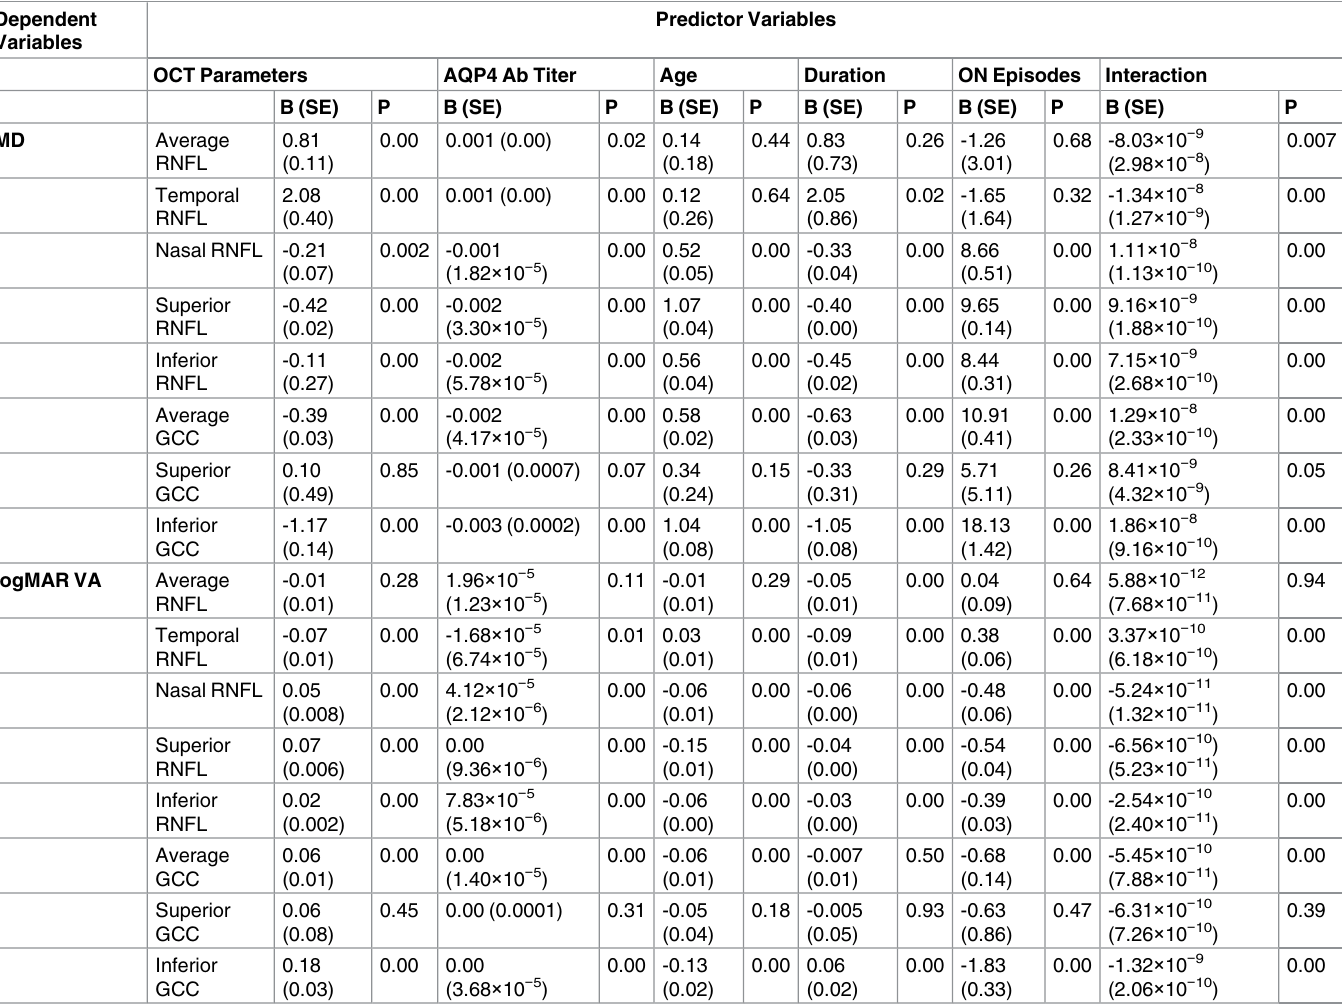
Table 8. Generalized Estimating Equation Regression Analysesfor Factors associated with Visual Function in Aquaporin-4 Antibody-Positive Eyes. Dependent Variables